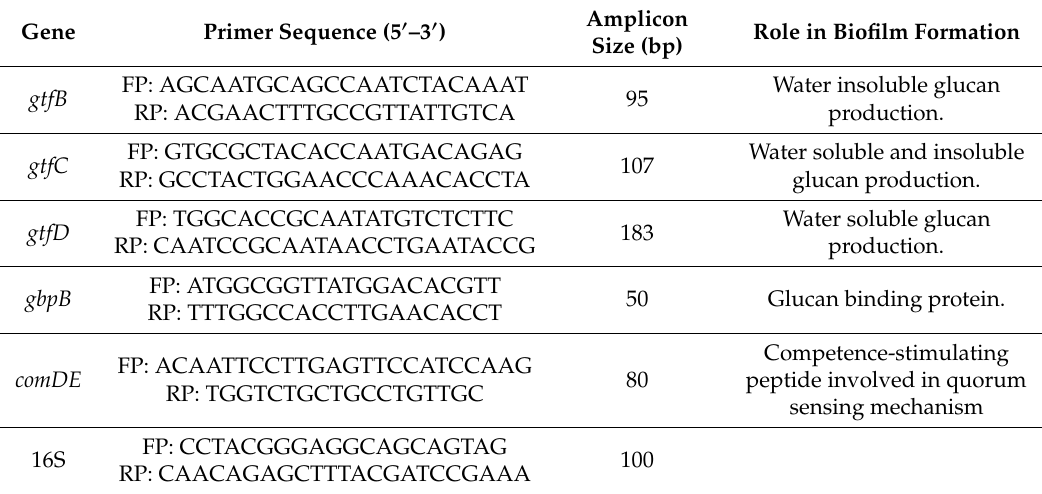
Table 1. Nucleotide sequences of primers used for relative quantification of expression pattern of genes involved in S. mutans biofilm